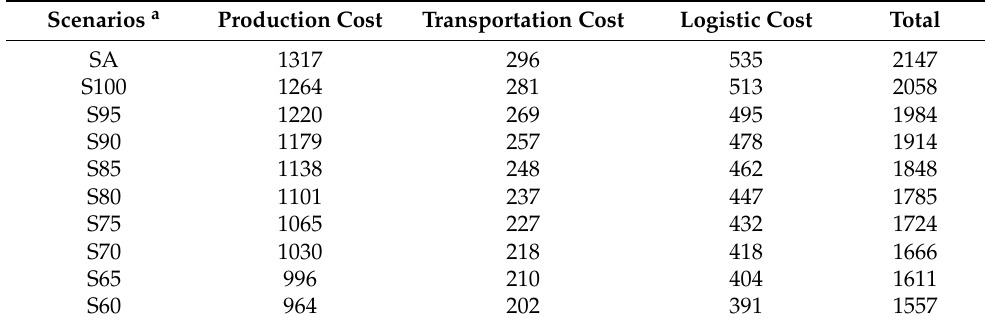
Table 5. Cost Associated with Each Scenario (million U.S. dollars).